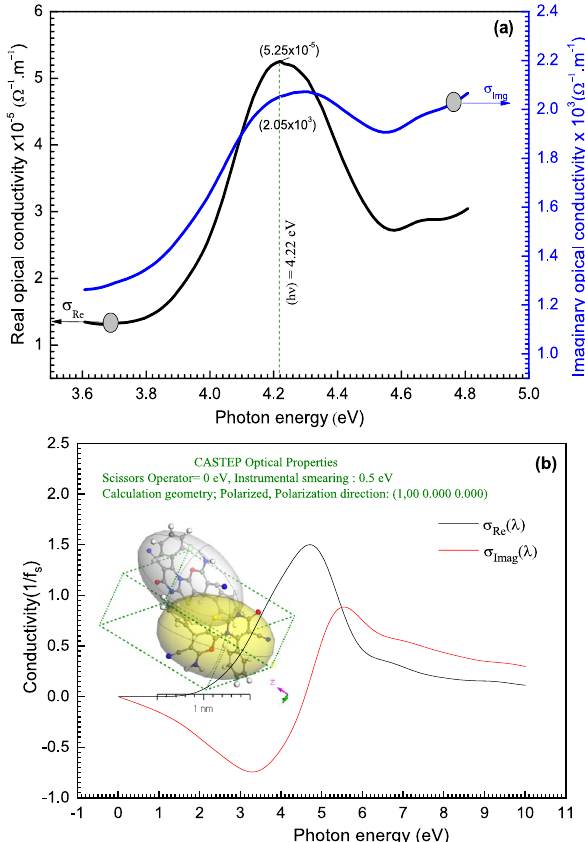
Figure 11. ( a ) The experimental σ Re (λ) and σ Imag (λ) for [ThiPy-3,8-Dc] TF . ( b ) Simulated σ Re (λ) and σ Imag (λ) for [ThiPy-3,8-Dc] Iso as an isolated state using the CASTEP